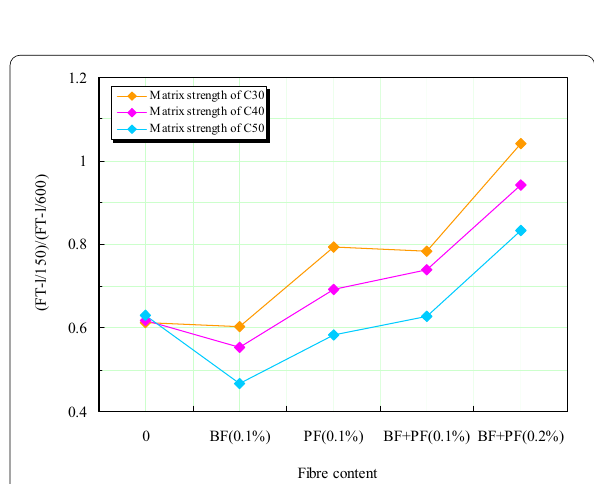
Fig. 13 Variation on ( FT - l /150)/( FT - l /600) with fiber type, fiber content and matrix